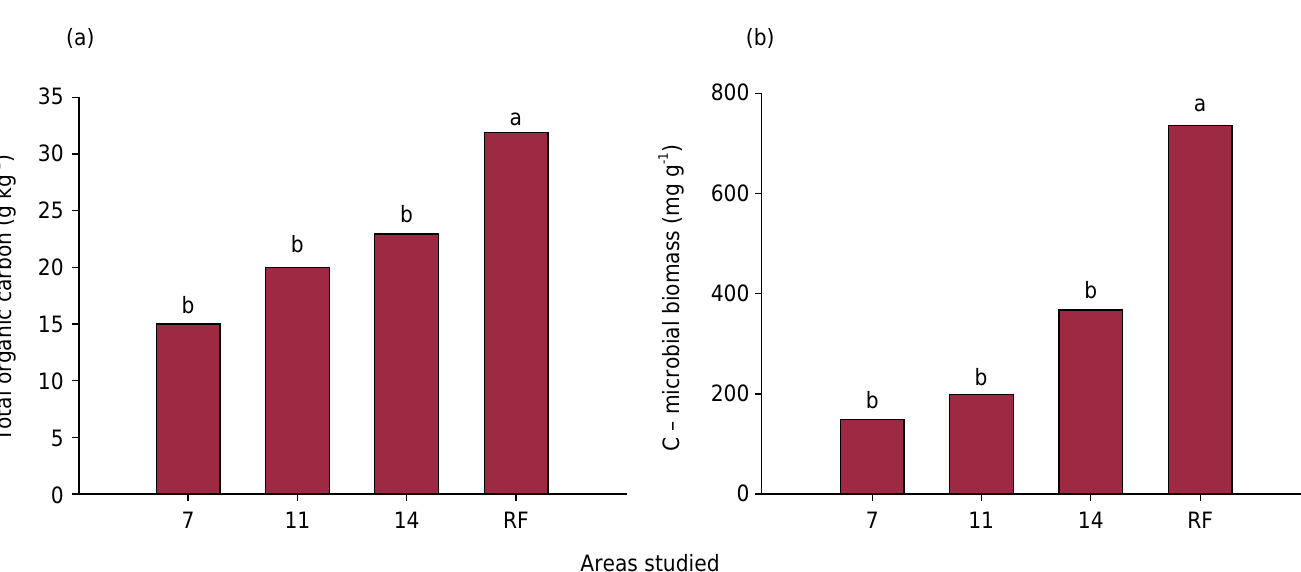
Figure 1. Content of the total organic carbon of the soil and microbial biomass carbon in the study areas. RF = reference area (murundus field); NT7 = area converted into no-tillage system for 7 years; NT11 = area converted into no-tillage system for 11 years; NT14 = area converted into no-tillage system for 14 years. Means followed by the same letter do not significantly differ from each other by the Tukey’s test at 5